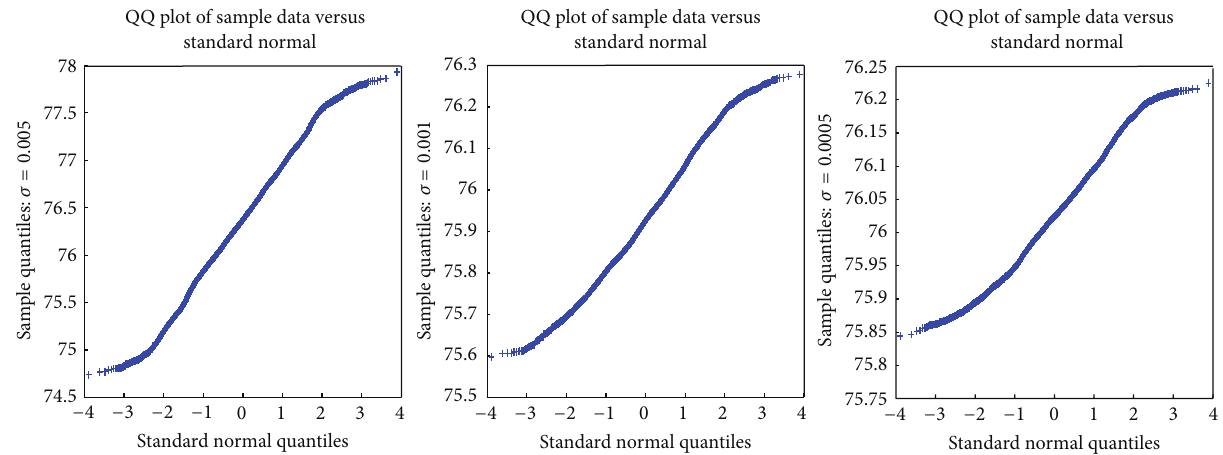
Figure 5: Normal quantile-quantile plots of the solution 𝐼(𝑡) for model (5) for 𝐼(0) = 10 and differing values of 𝜎 = 0.005 , 𝜎 = 0.001 , and 𝜎 = 0.0005